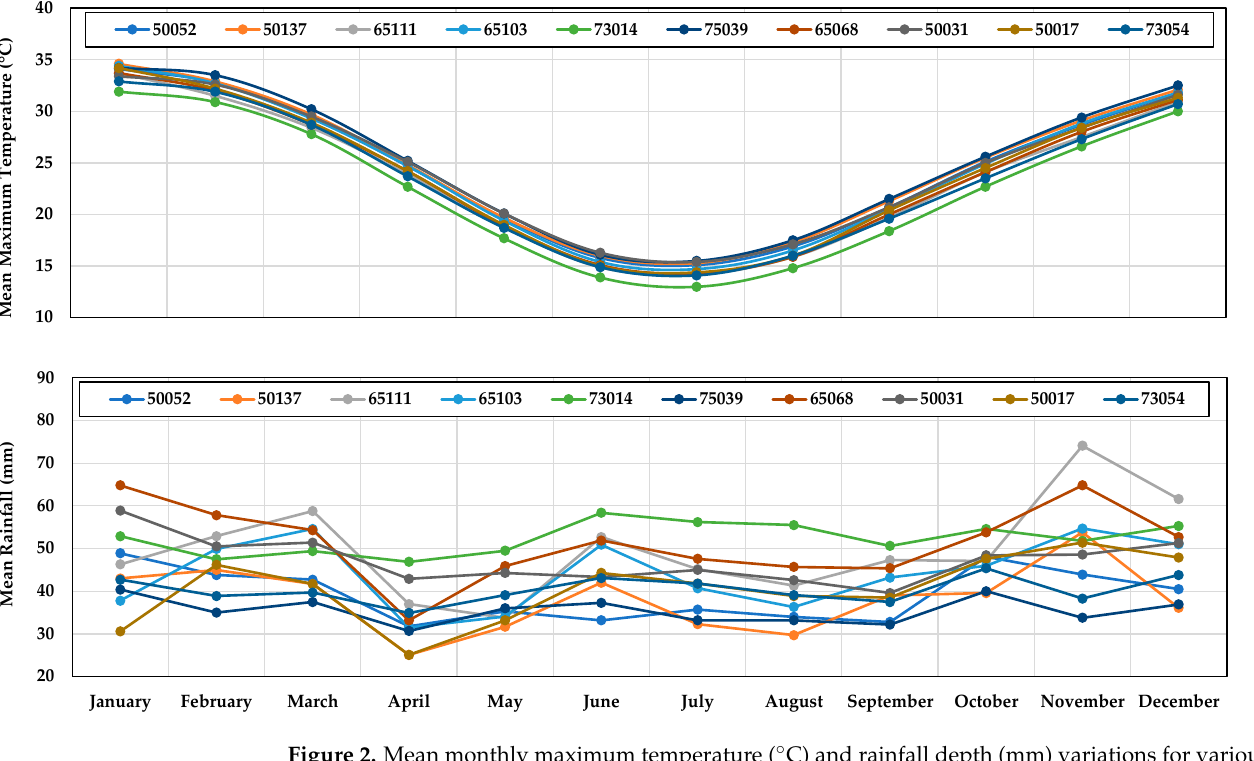
Figure 2. Mean monthly maximum temperature (°C) and rainfall depth (mm) variations for various stations (check Table 1 for the station names).